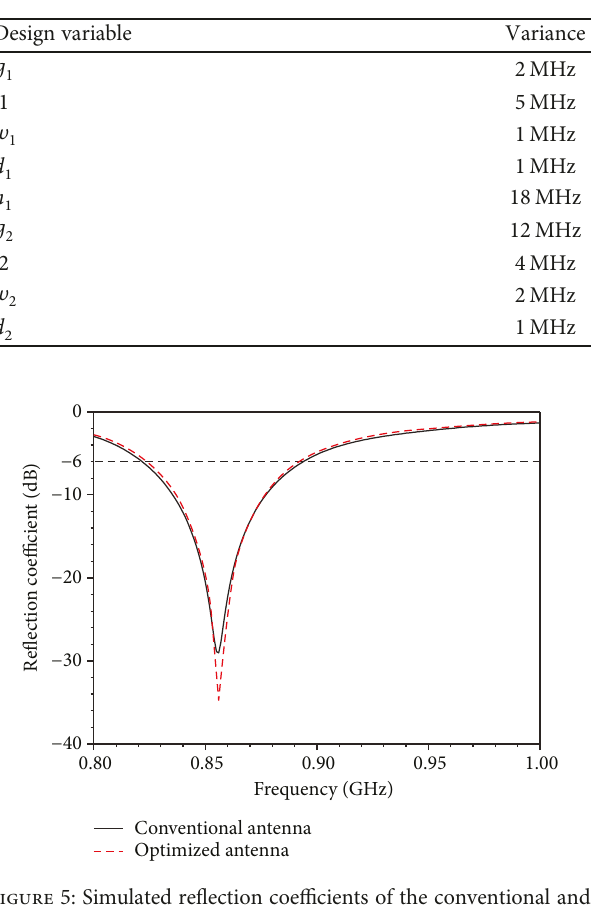
Figure 5: Simulated re fl ection coe ffi cients of the conventional and optimized antennas.